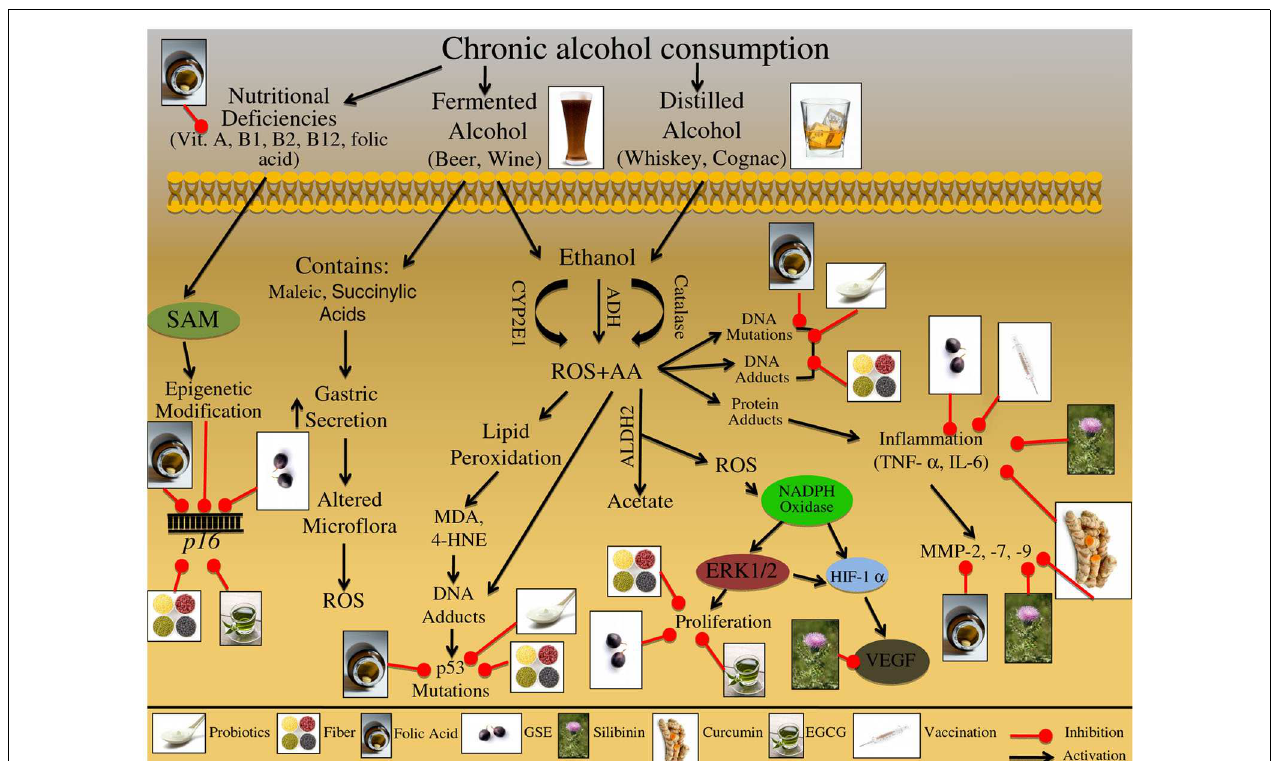
then result in DNA mutations, specifically in the p53 gene, which contributes to the initiation and promotion of CRC. AA alone is a mutagenic compound known to form adducts with DNA and proteins, as well as, induce DNA mutations; furthermore protein adduct formation has been shown to induce inflammatory responses viaTNF- α and IL-6.These inflammatory mediators further regulate the expression of matrix metalloproteinase MMP-2, -7, and -9, which are involved in the promotion and progression of CRC. Additionally AA can be oxidized by aldehydes dehydrogenase 2 (ALDH2) resulting in acetate and ROS formation; these ROS species have been indicated in the activation of NADPH oxidase. NADPH oxidase is an enzyme complex that further modulates downstream effectors proteins, such as ERK1/2 and HIF-1 α signaling; this down stream protein modification results in alteration of proliferative and metastatic signaling pathways, which are involved in CRC promotion and progression.The illustration also denotes the modulatory role of lifestyle interventions at various levels on these aberrant signaling pathways.The photographs of lifestyle interventions were sourced and adapted from